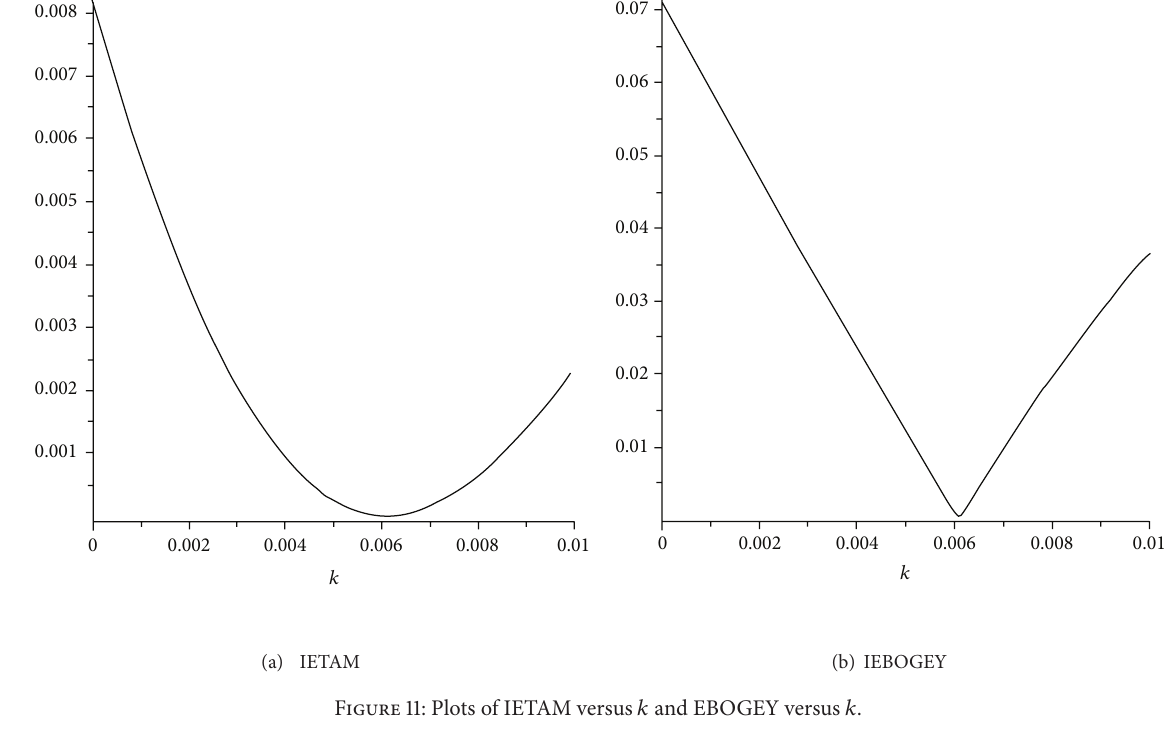
Figure 11: Plots of IETAM versus 𝑘 and EBOGEY versus 𝑘